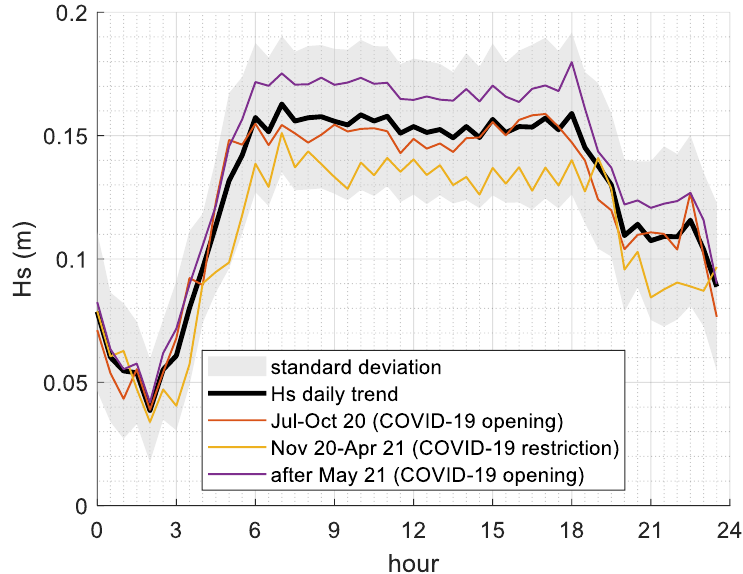
Figure 3. Daily trend caused by boat traffic in the San Marco basin based on the recorded wave series (black line). The other line indicates the daily trend affected by the main measures adopted by the Italian government during the COVID-19 pandemic.